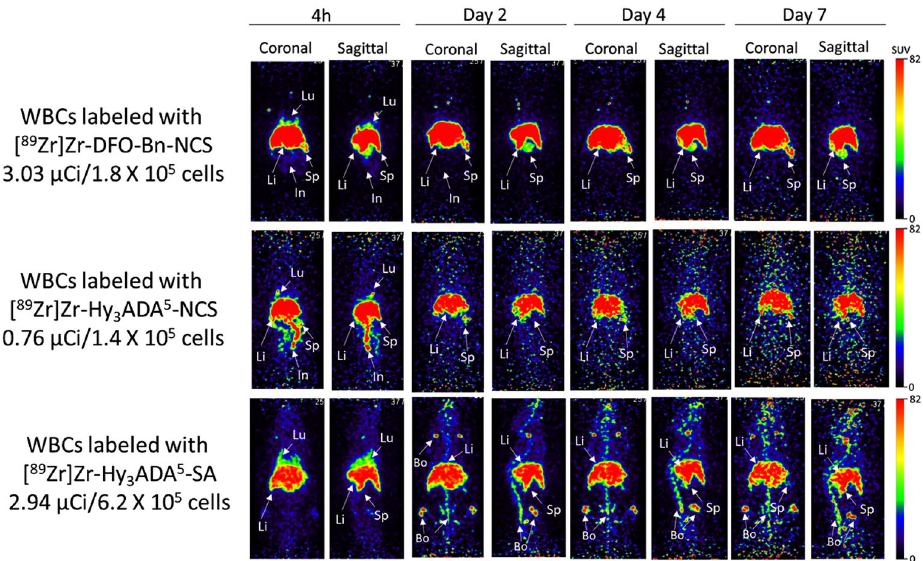
Figure 5. Representative coronal and sagittal PET maximum intensity projection (MIP) images showing distribution of WBCs labeled with [ 89 Zr]Zr-DFO-NCS, [ 89 Zr]Zr-Hy 3 ADA 5 -NCS and [ 89 Zr]Zr-Hy 3 ADA 5 -SA synthons in athymic nude mice at different time points post-injection.